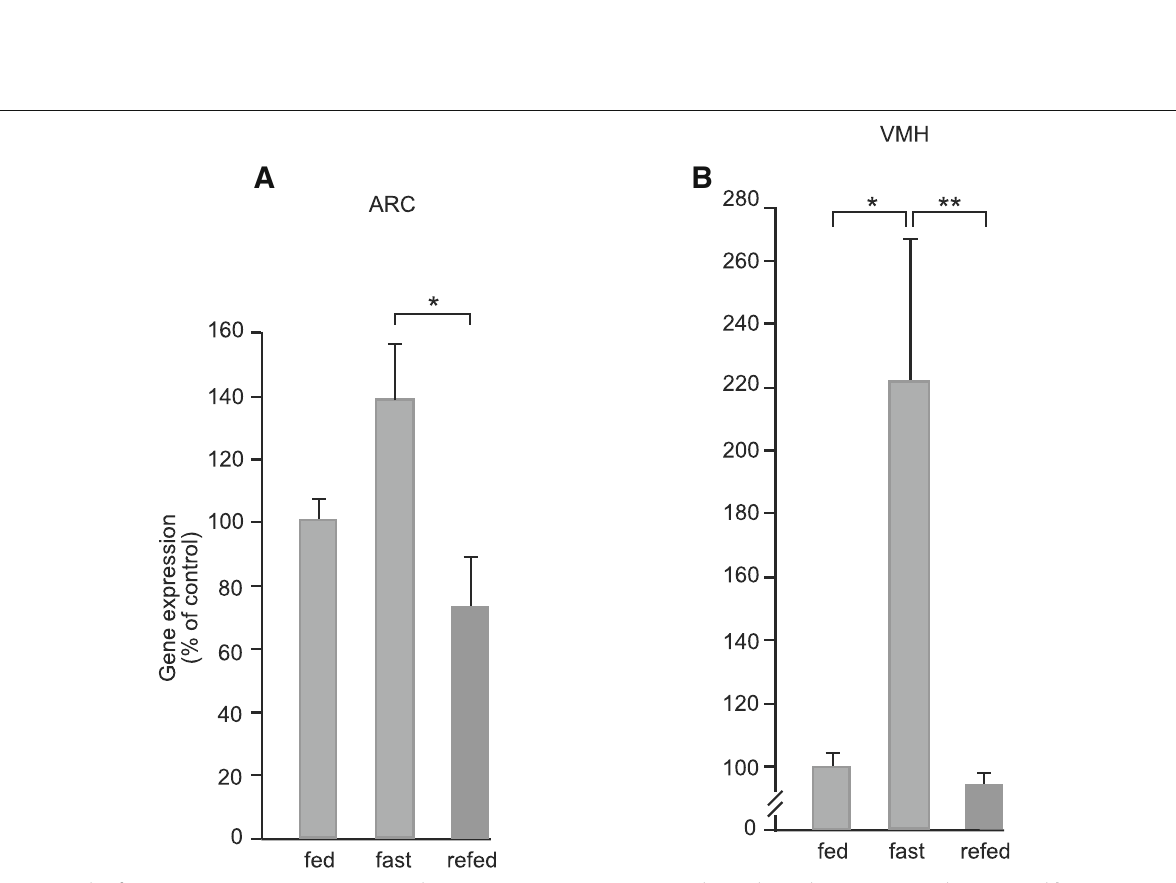
Fig. 6 Levels of serpinA3N gene expression measure by semi-quantitative in situ autoradiography in the a arcuate nuclei (ARC) and b ventromedial nuclei of the hypothalamus (VMH) of C57Bl/6J mice either fed, fasted for 24 h or refed for 24 h. * P < 0.05, ** P < 0.01 ( n =